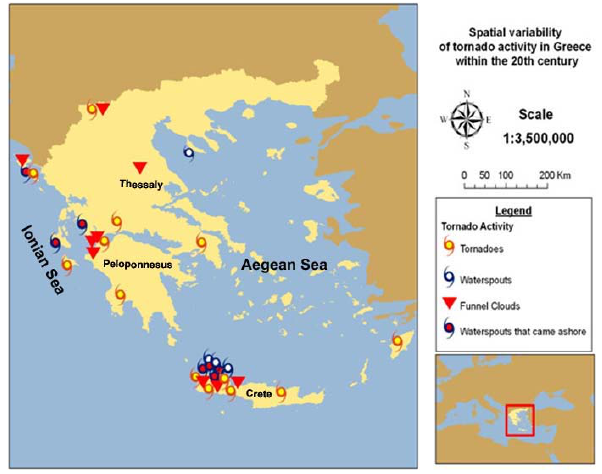
Figure 1 . Spatial variability of tornado activity in Greece within the 20 th century. Fig. 1. Spatial variability of tornado activity in Greece within the 20th century.